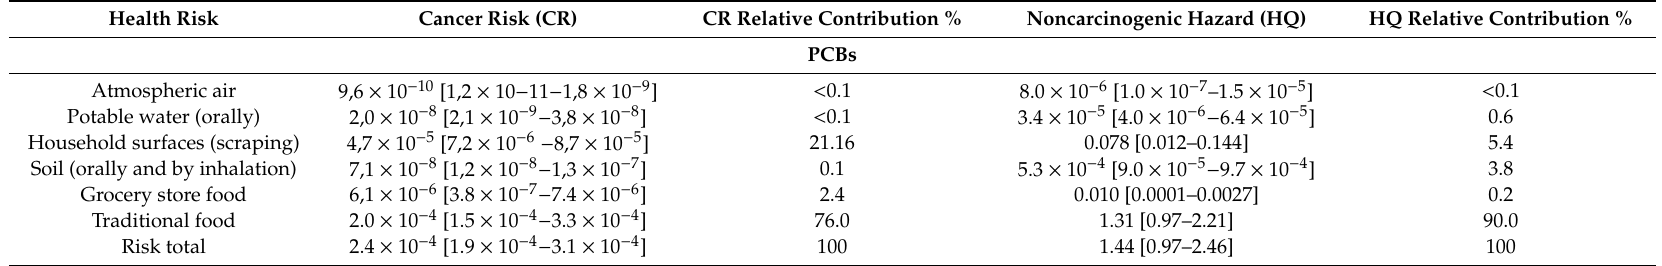
Table 2. Exposure pathway-specific health risks of PCBs estimated for a coastal indigenous population of Chukotka (the village of Uelen in 2010 n = 86 aged 21–67